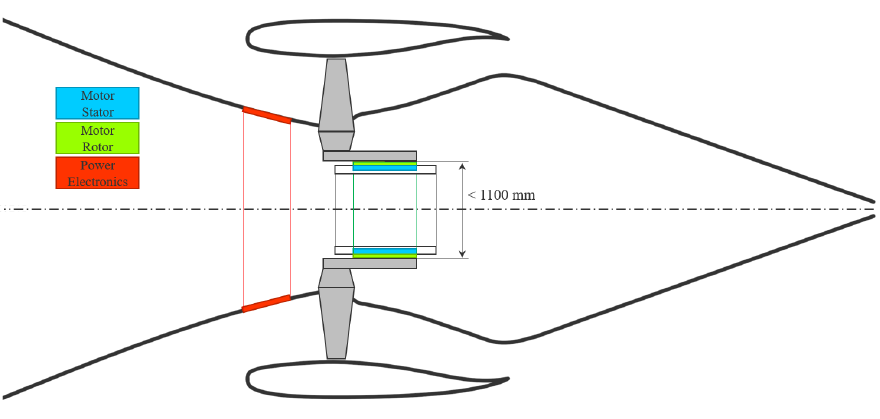
Figure 2. Fuselage fan drive unit integration with installation space limitations (taken from [27] and